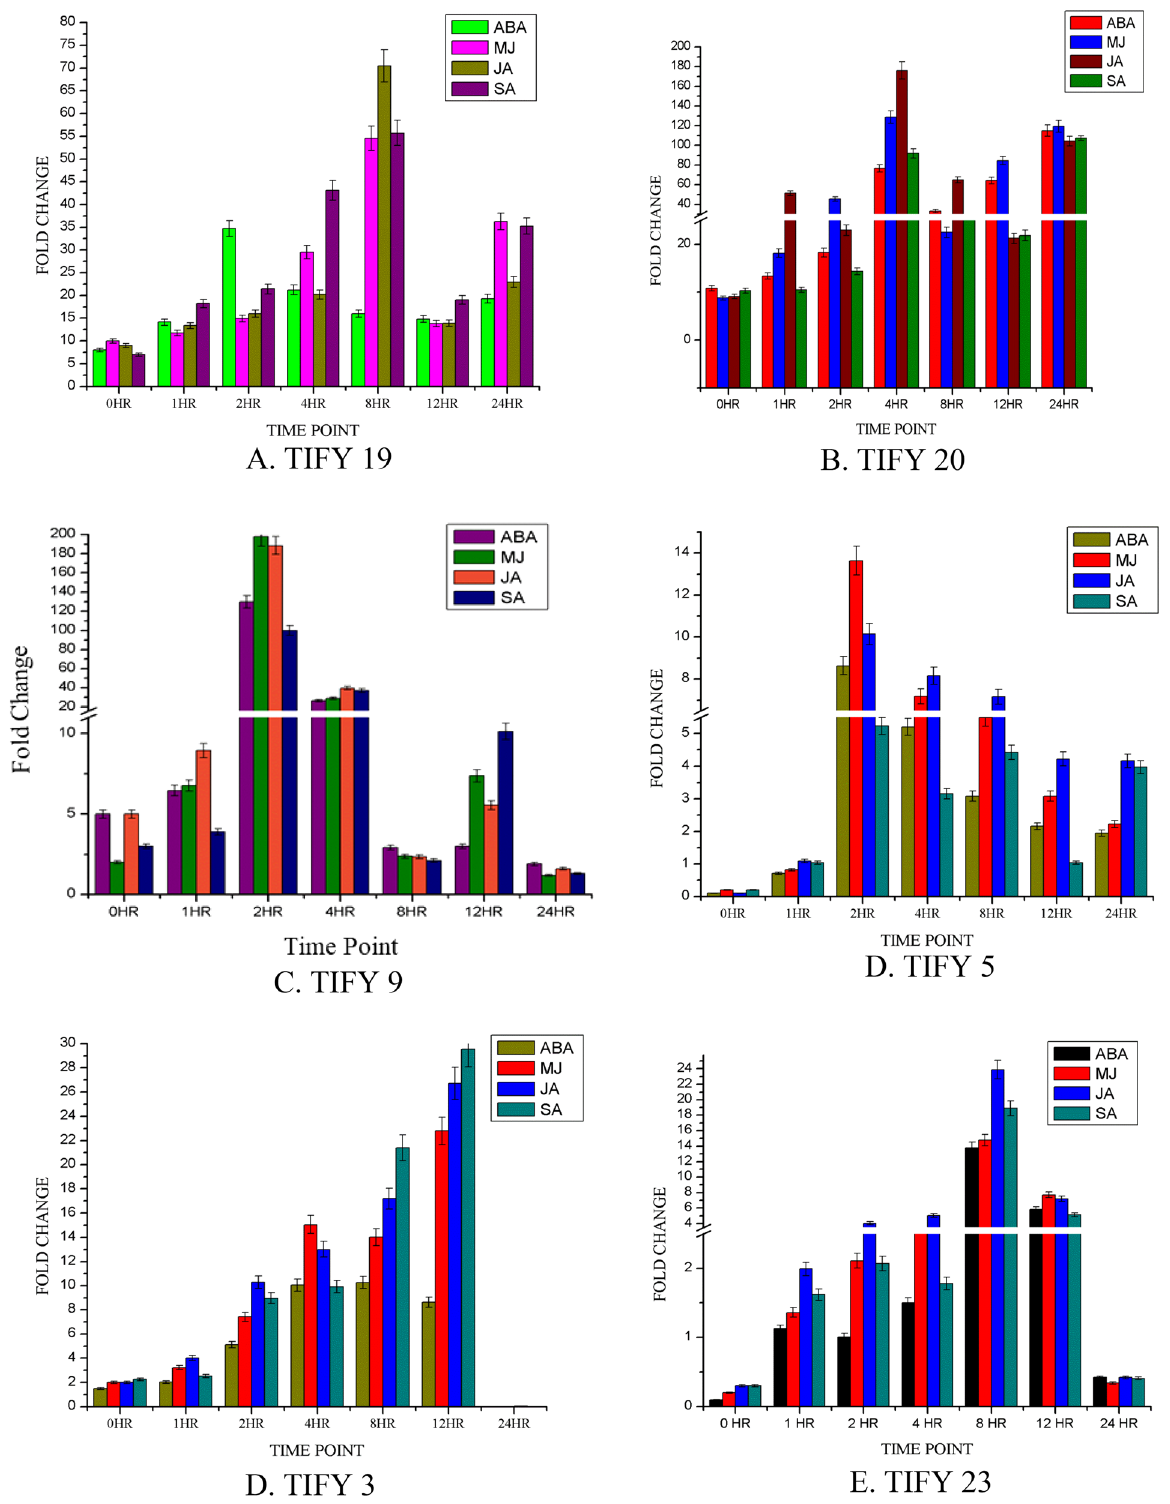
Figure 9. Spatio-temporal expression of TaTIFY family genes during abiotic